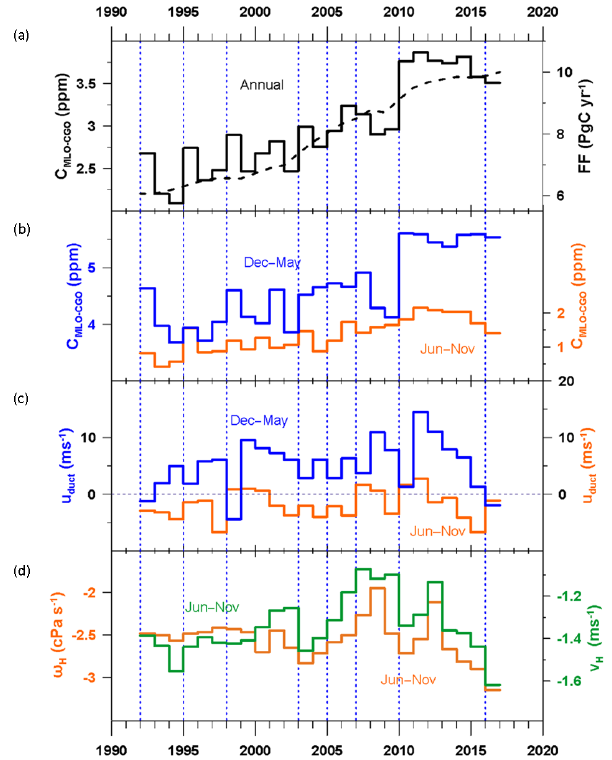
Figure 2. (a) Annual average C mlo − cgo (solid) and global CO 2 emission estimate (dashed) for 1992 to 2016, (b) C mlo − cgo for bo- real winter–spring (blue) and summer–autumn (orange), (c) u duct for boreal winter–spring (blue) and summer–autumn (orange), and (d) boreal summer–autumn ω H , (orange) and v H